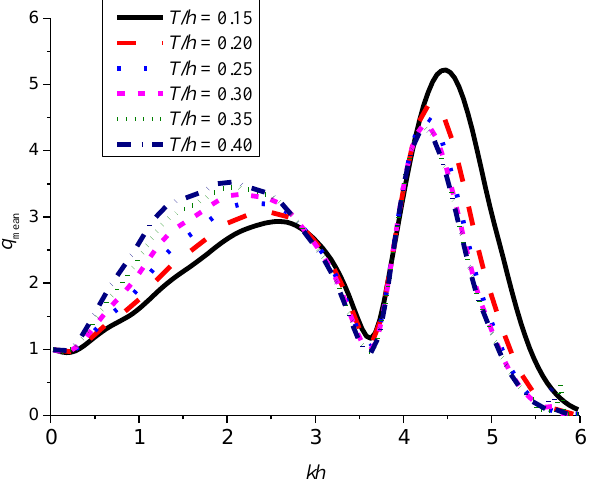
Figure 12. Variations of q mean vs. kh for the WEC array with different drafts T of the rear pontoon.